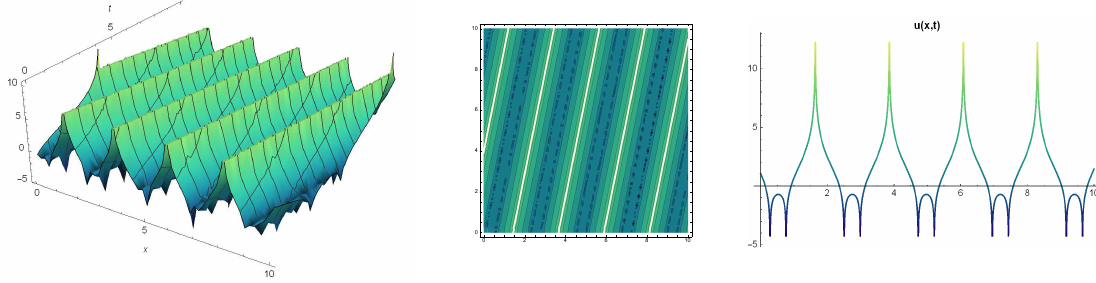
Figure 6. 3D, contour and 2D graphs respectively c 2 = − 0.5, c 1 = − 1, a 0 = 0.5, p = − 0.2, λ = 2, a 2 = − 2 values of Equation